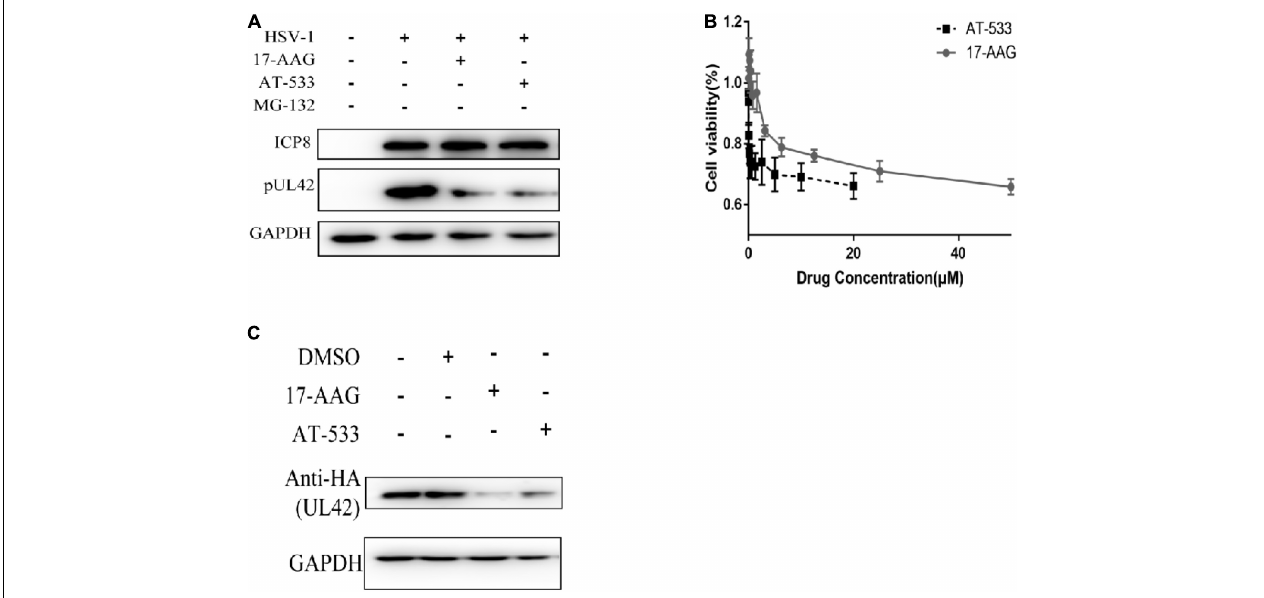
FIGURE 3 | Hsp90 is required for the maintenance of UL42 stability. (A) HFF cells were infected with HSV-1 (MOI = 20) and treated with 1.0 µ M AT-533 and 6.25 µ M 17-AAG at 4 hpi. Western blot was assayed to detect the replication-related viral proteins at 12 hpi. (B) HEK293 cell monolayers were treated with concentration-gradient AT-533 and 17-AAG for 48 h and were manipulated to CCK-8 assay. Data are shown as means ± SEM. (C) After being transfected with HA-Vector and HA-UL42 plasmid for 48 h, HEK293 cells were refreshed with 2% FBS DMEM containing 1.0 µ M AT-533 or 6.25 µ M 17-AAG at 6 hpi, and cell lysates were subjected to Western blot assay at 12